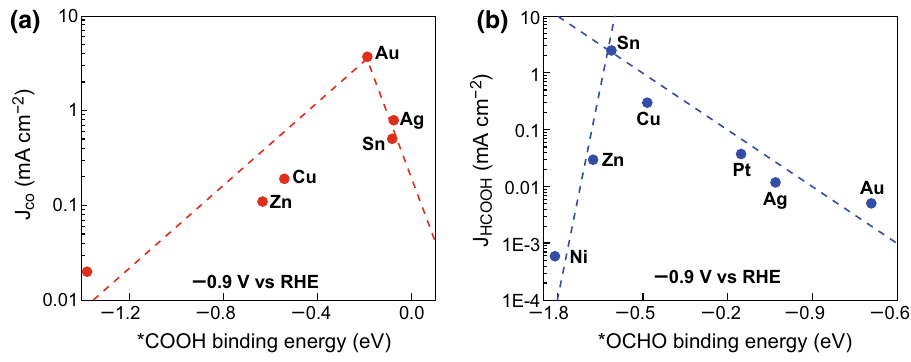
Fig. 2 a Volcano plot using · COOH binding energy as a descriptor for CO partial current density at − 0.9 V (vs. RHE). b Volcano plot using · OCHO binding energy as a descriptor for HCOO − partial current density at − 0.9 V (vs. RHE). Reprinted with permission from Ref.